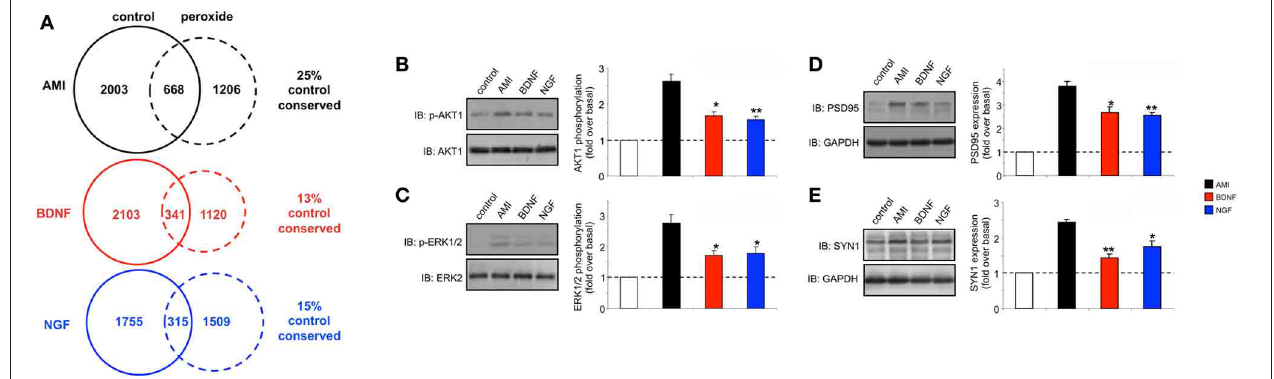
AMI (20min treatment) possesses a significantly better ability to activate AKT1 and ERK1/2 (C) in peroxide pre-treated cells compared to BDNF (red bars) or NGF (blue bars). AMI (48h treatment) also possessed a significantly greater ability to elevate the expression of PSD95 (D) and synapsin I (E) in peroxide pre-treated cells compared to BDNF or NGF. Statistical significance was measured over three independent experiments